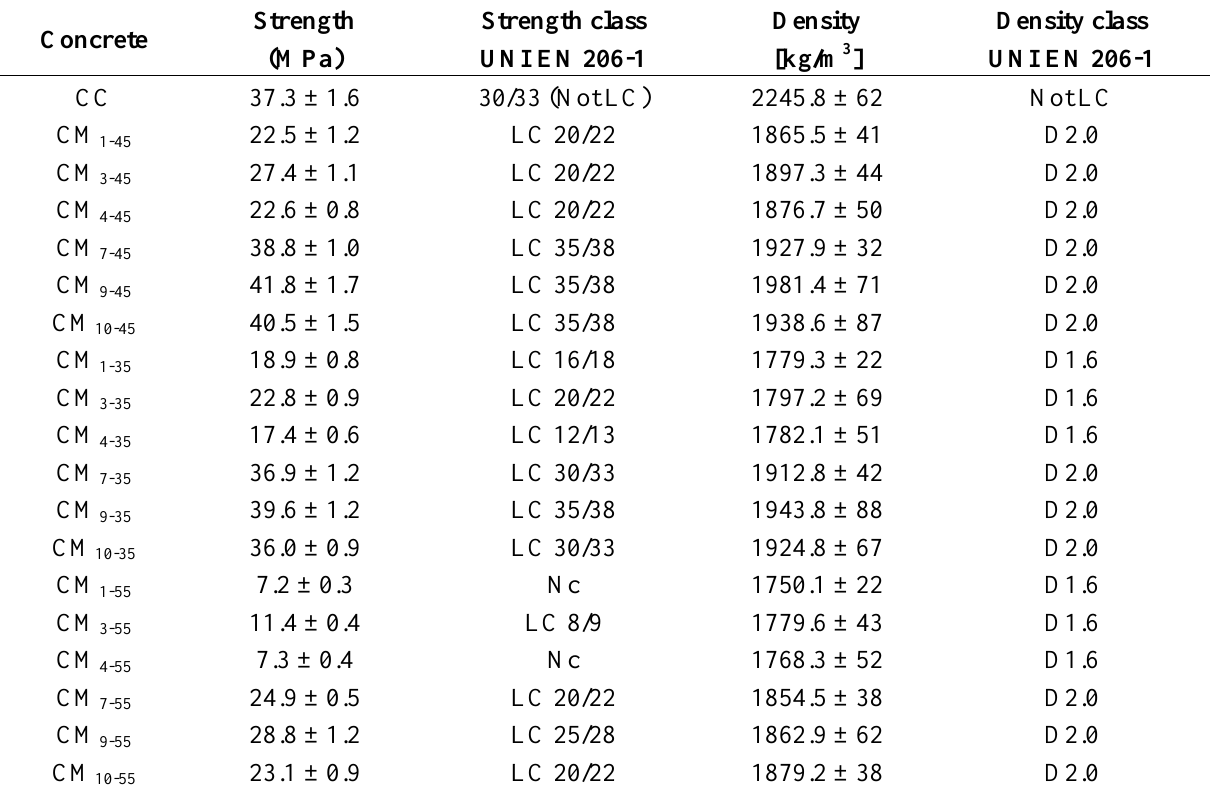
Table 7. Physical and mechanical characterization of concrete according to UNI EN 206-1.